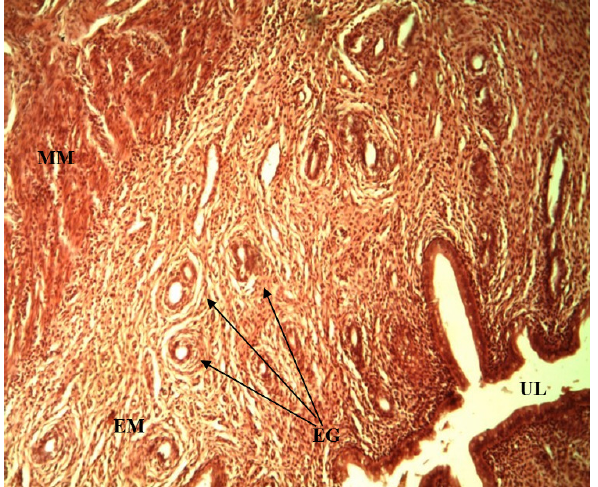
Fig. 5. Photomicrograph of a section of the uterus of group C (800 mg/kg) rats (stained with H & E; × 10). The myometrium (MM) and endometrial (EM) layers, with the endometrial layer bearing endometrial glands (EG) part of the uterine lumen (UL) are evidenced